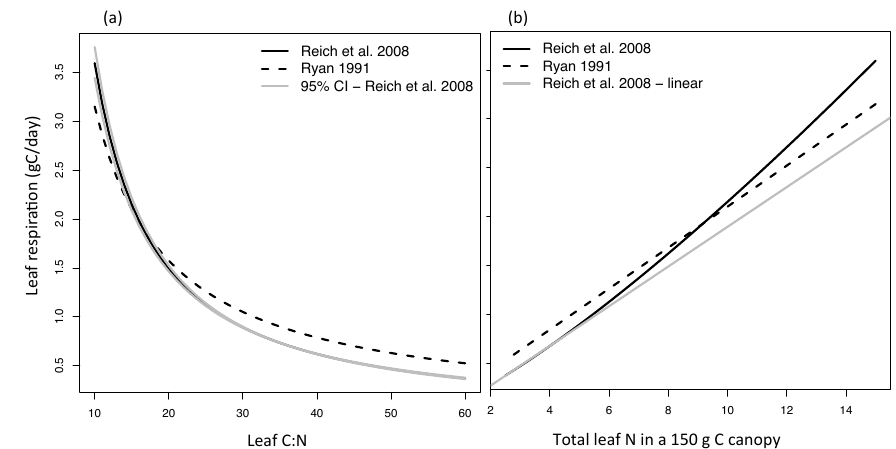
Figure 5. Leaf respiration increases non-linearly with leaf N using the Reich et al. (2008) parameterization and linearly with leaf N using the Ryan (1991) parameterization. Total canopy leaf respiration for a plant with 150gCm − 2 canopy is shown as a function of leaf N, expressed on a leaf C : N basis (a) and a total canopy leaf N basis (b) . The 95% uncertainty from Reich et al. (2008) is shown as gray lines in (a) . The non-linearity of the Reich et al. (2008) equation is illustrated by extrapolating the initial slope (gray line) in (b)